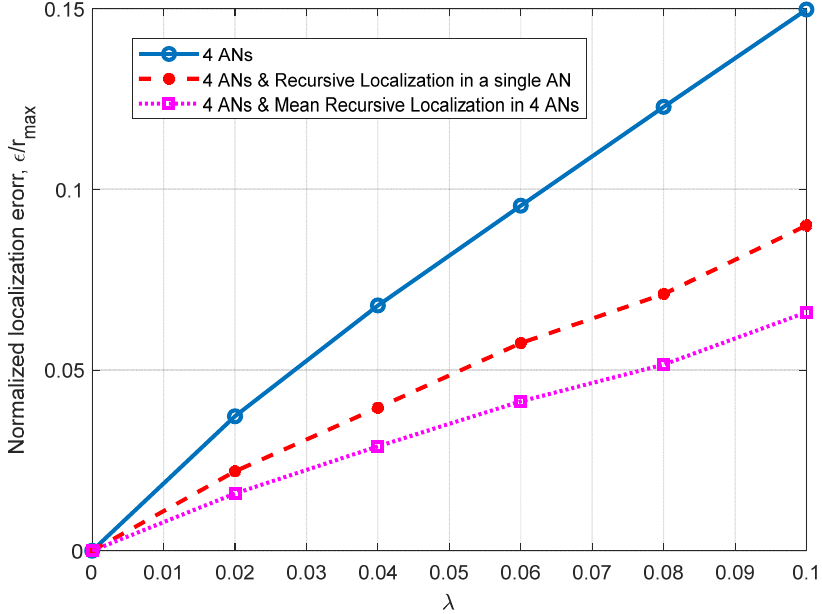
Figure 6. Normalized mean squared error ε / r max vs. exponentially distributed distance error with parameter λ , considering four ANs, single and mean recursive localization and r max = 10 m.